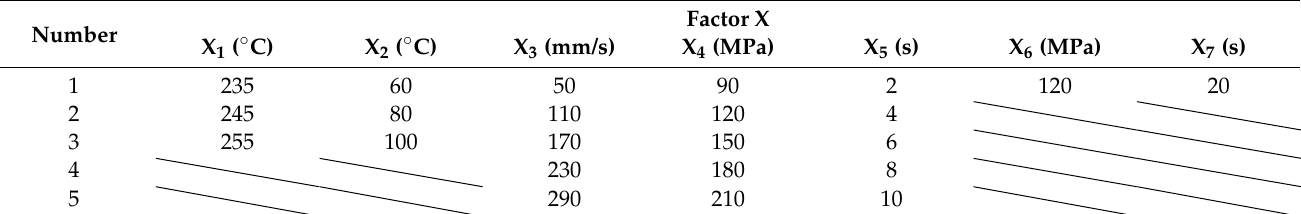
Table 2. Uniform table remarking U15 (32 × 53) in µ IM.